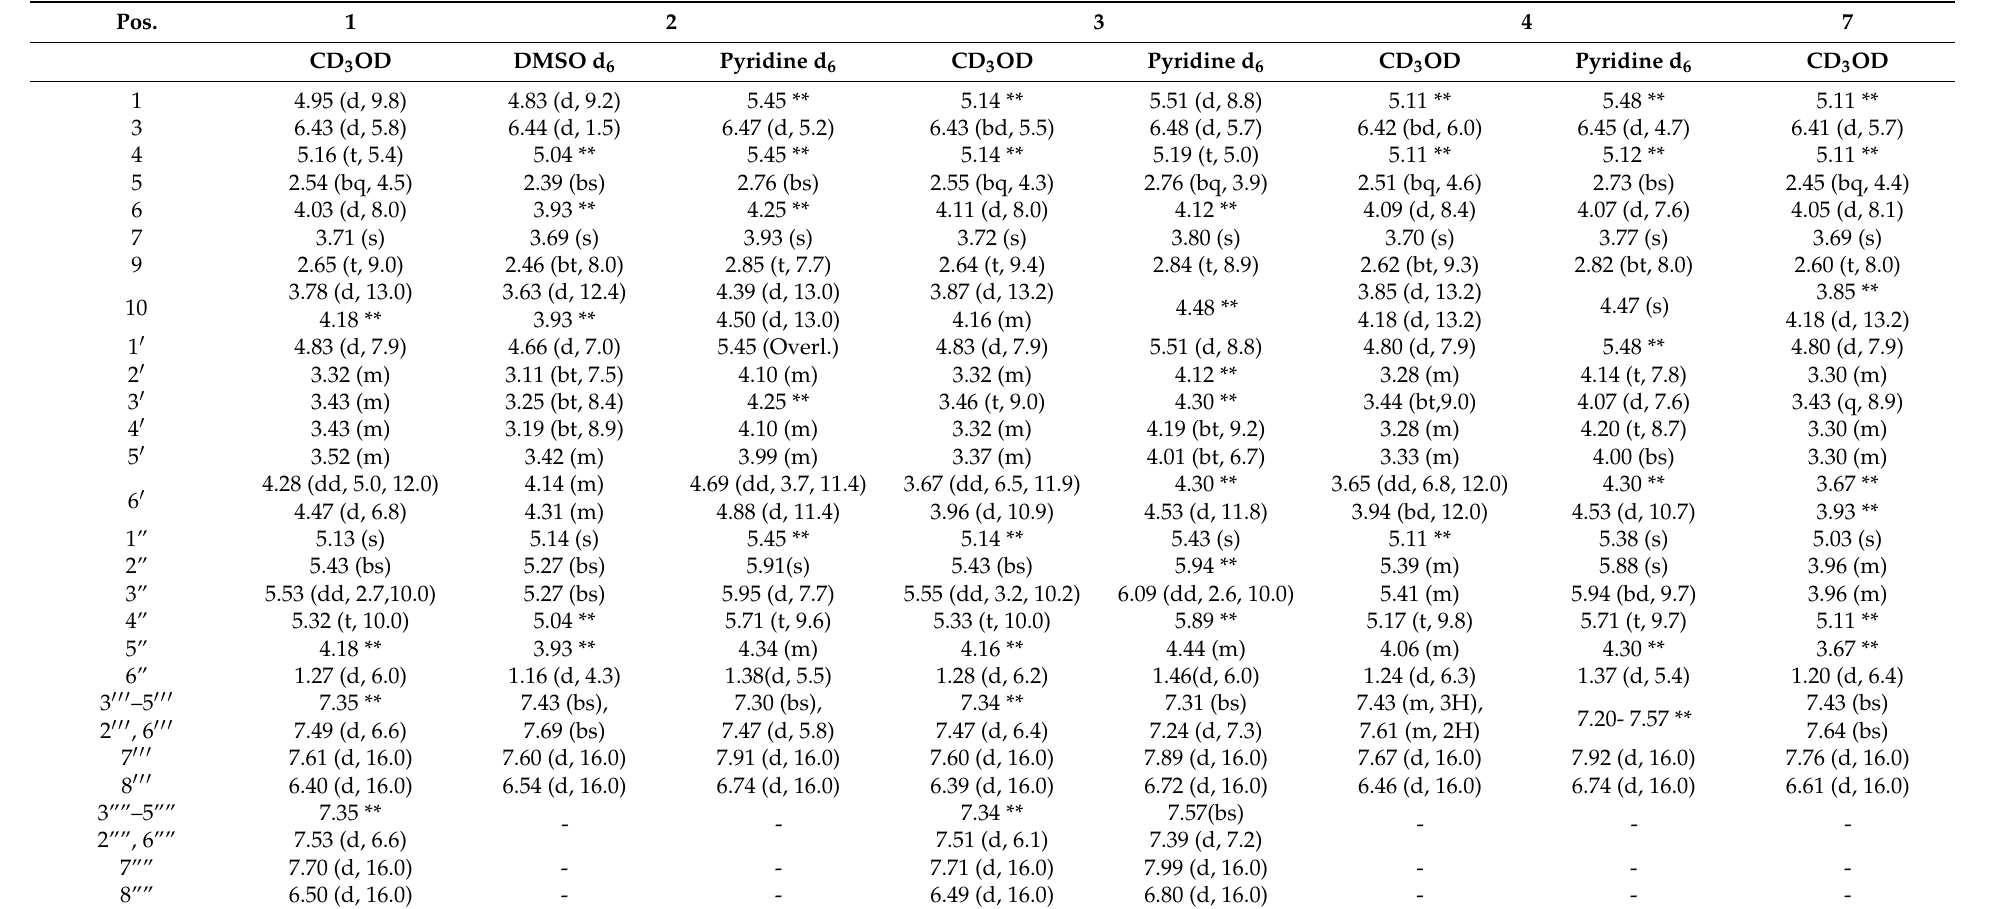
Table 1. 1 H NMR data ( δ ppm, J in parentheses in Hz) for compounds 1–4 and 7